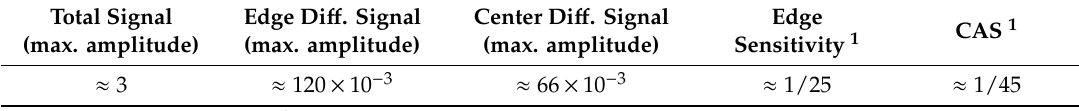
Figure 11. Current and signal calculations with an undulator setup (cf. Figure 3c); (left) Eddy current distribution in the horizontal middle plane of a conducting and travelling volume, shown at three characteristic positions A, B and C. Local voids at four characteristic positions inside the travelling volume (blue, green, orange and red squares) are analyzed; (right) Total signal (dotted black) and differential signals (blue, green, orange and red lines) for the four voids. Table 6. The main results from the calculated signals, shown in Figure 11. T able 6. The main results from the calculated signals, shown in Figure 11. Total Signal